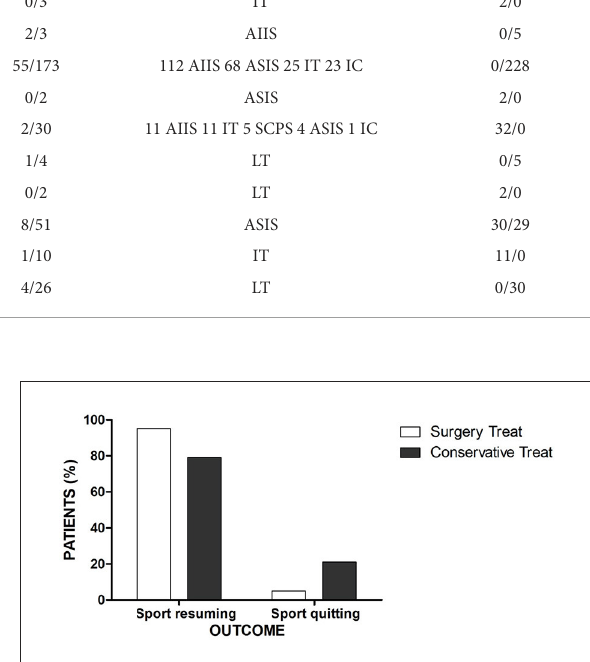
FIGURE3 Histogram of rate to return to sport in surgical and conservative